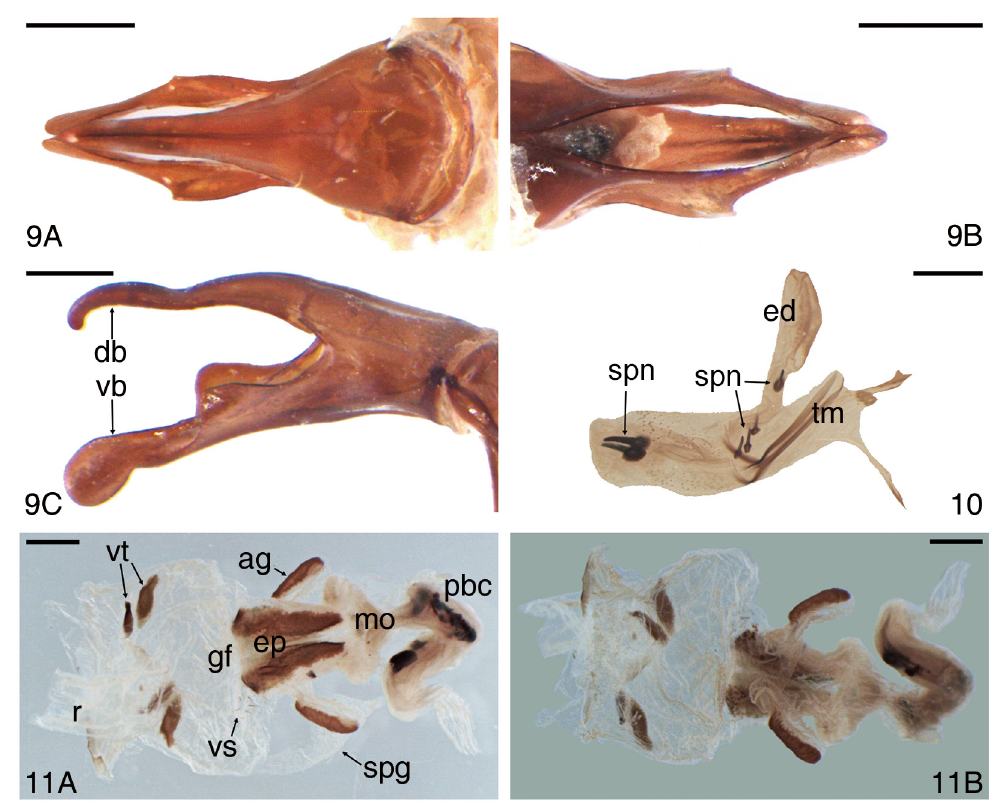
Figs 9–11. Morphotype IV “ Bidentata ”. 9–10 . Male genitalia of M. behrensi Brenske, 1892, lectotype (MFNB). 9 . Parameres in dorsal (A), ventral (B) and lateral (C) views. 10 . Endophallus and temones in ventral view. 11 . Female genitalia of M. saigonensis (Moser, 1912), ?syntype (MFNB) in dorsal (A) and ventral (B) views. Scale bars = 1.0